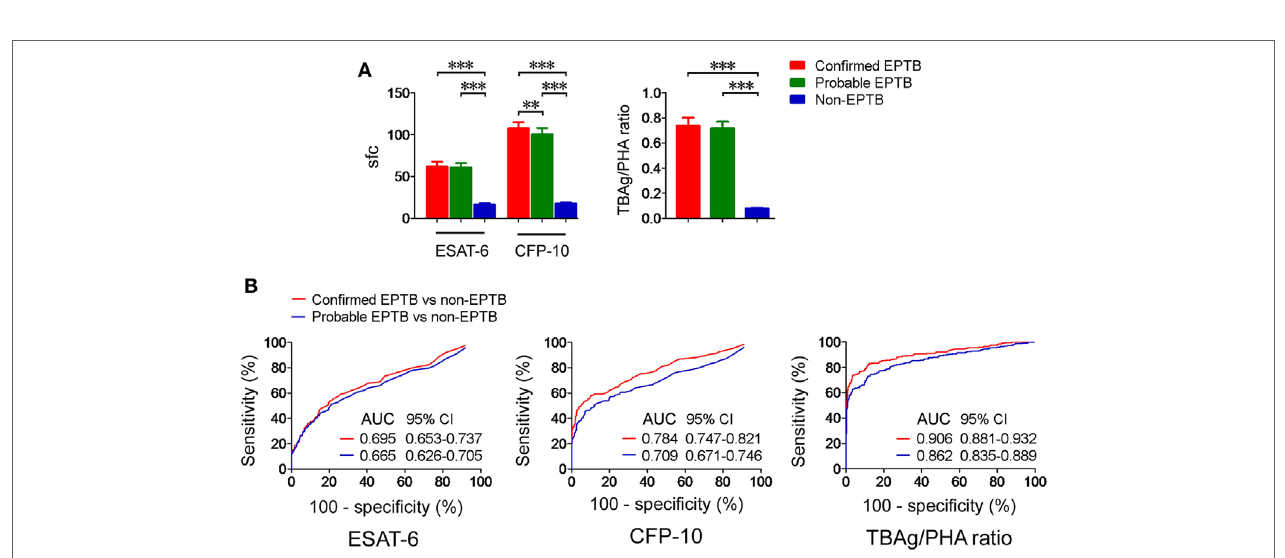
FigUre 2 | The TBAg/PHA ratio in confirmed and probable EPTB patients. (a) Histograms showing ESAT-6 sfc, CFP-10 sfc, and the TBAg/PHA ratio in T-SPOT positive patients with confirmed EPTB ( n = 273), probable EPTB ( n = 374), and non-EPTB ( n = 367). Data are shown as the mean ± SEM (** p < 0.01 and *** p < 0.001). (B) Receiver operating characteristic analysis was performed for ESAT-6 sfc, CFP-10 sfc, and the TBAg/PHA ratio in distinguishing between confirmed EPTB and non-EPTB or between probable EPTB and non-EPTB. Abbreviations: EPTB, extrapulmonary tuberculosis; ESAT-6, early secreted antigenic target 6; CFP-10, culture filtrate protein 10; AUC, area under the curve; CI, confidence intervals; TBAg, TB-specific antigen; PHA, phytohemagglutinin; sfc, spot-forming cells.